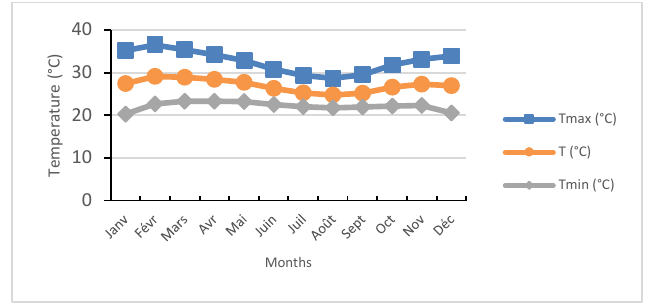
Figure 4: Minimum, average, and maximum temperatures of the synoptic station 2000-2017